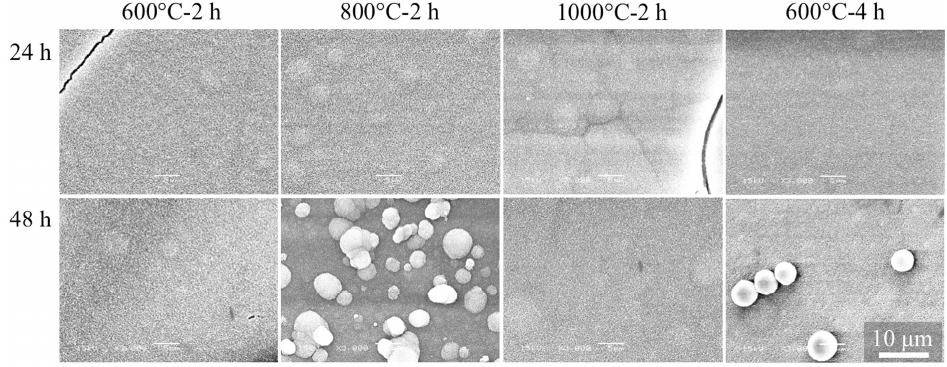
Figure 7. SEM images of the Y ‐ TZP disks from four heating conditions after 24 and 48 h of HBSS immersion.